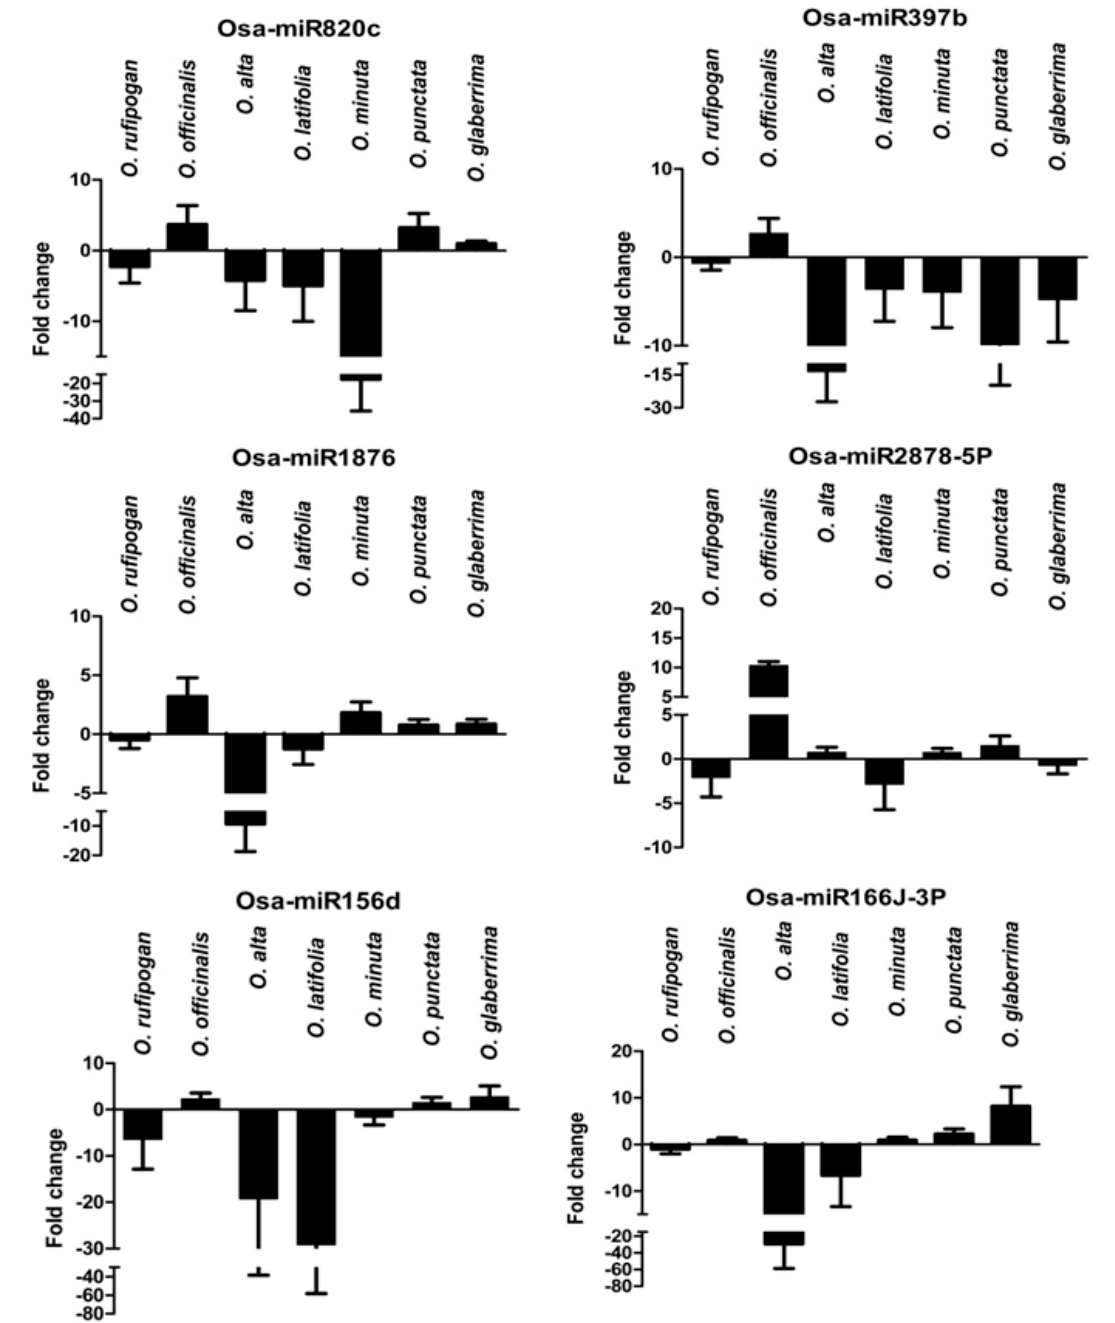
Figure 7. RT-qPCR expression analysis of miRNAs in wild rice species. Data is represented after internal reference gene U6 normalization. The error bars represent the standard error of three biological replicates. X -axis: samples and Y -axis: fold change expression in the fungal-infected sample in comparison to the respective controls.